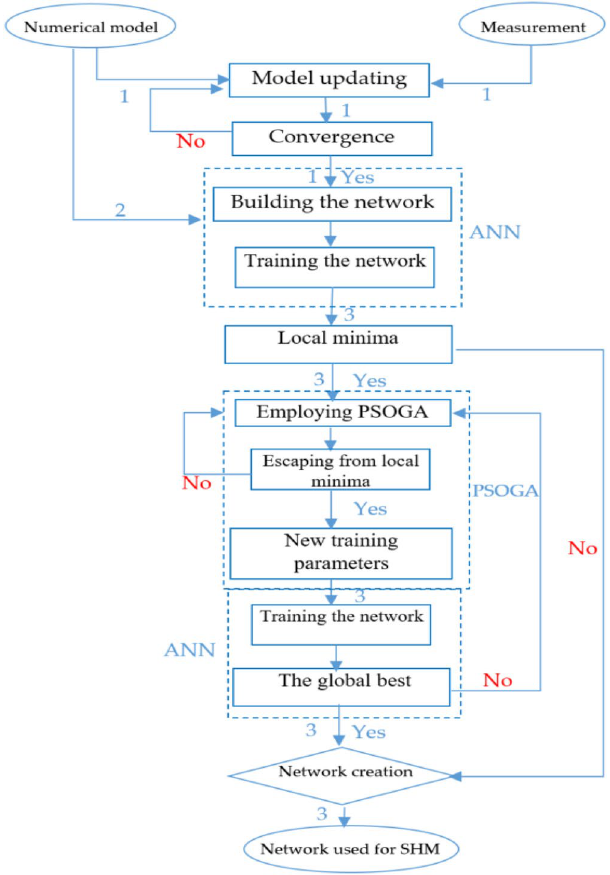
Figure 3. The diagram of the proposed approach.